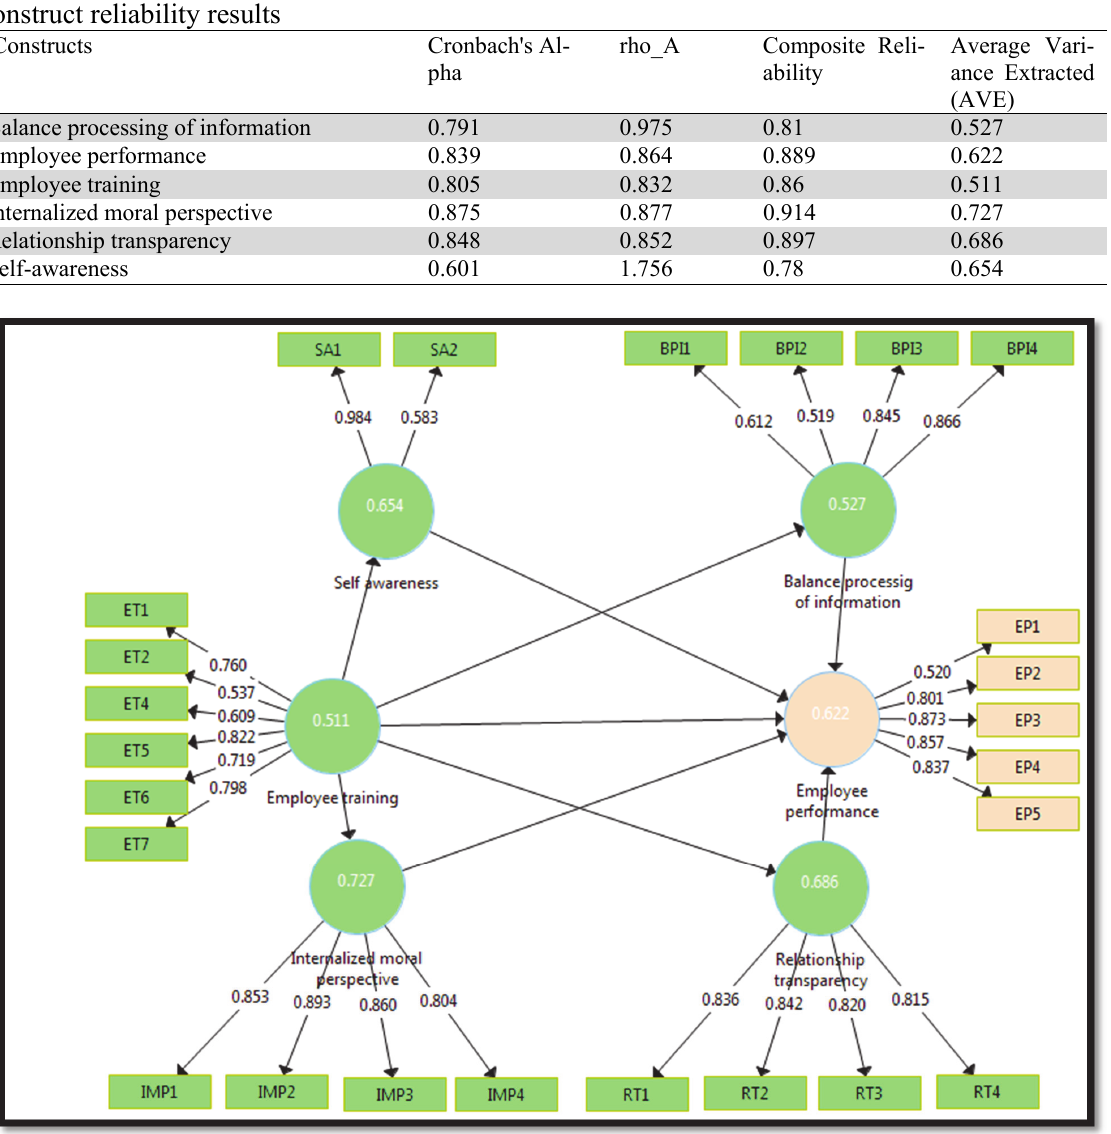
Fig. 2. Results of construct